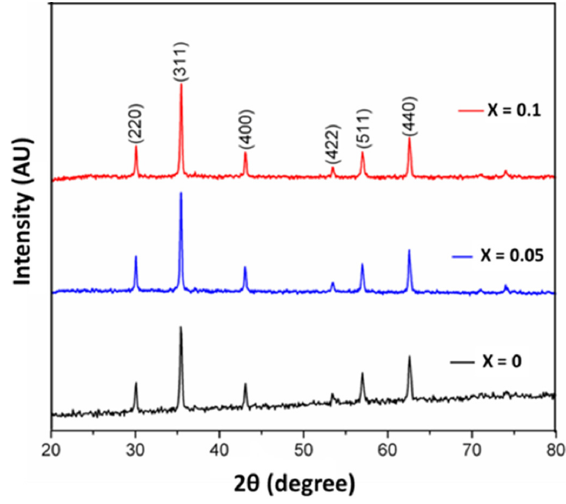
Figure 2. The XRD pattern of heat-treated MgFe 2-x O 4- δ (x = 0, 0.05, and 0.1) materials. Table 1. The crystallite size and lattice parameter of MgFe 2-x O 4- δ (x = 0, 0.05, and 0.1) materials. Sample ID